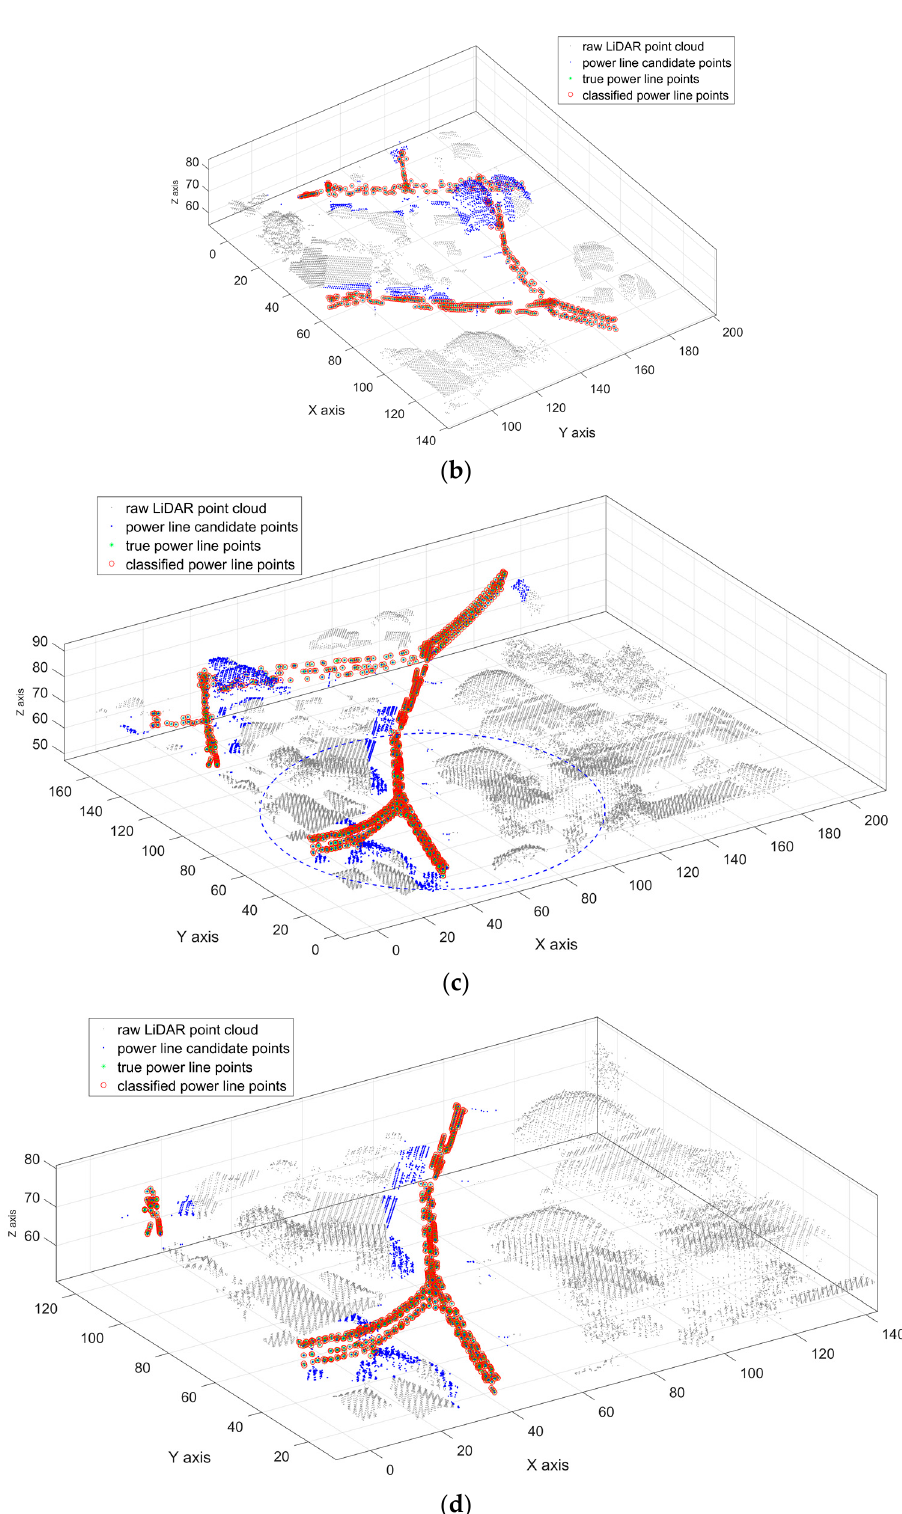
Figure 5. Visualization of the experiment results for power line classification of UL Dataset. ( a ) is the whole area results in XOY plane involving the raw LiDAR point cloud, power line candidate points, true power line points and classified power line points; ( b ) is the local magnification of the blue dashed ellipse area in ( a ) in power line corridor direction; ( c ) is the whole area results in 3D view; ( d ) is the local magnification of the blue dashed ellipse area in ( c ).